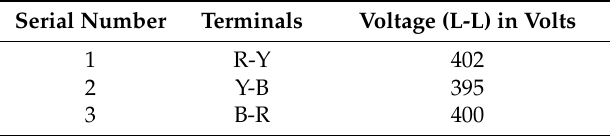
Table 7. Output voltages of the phase